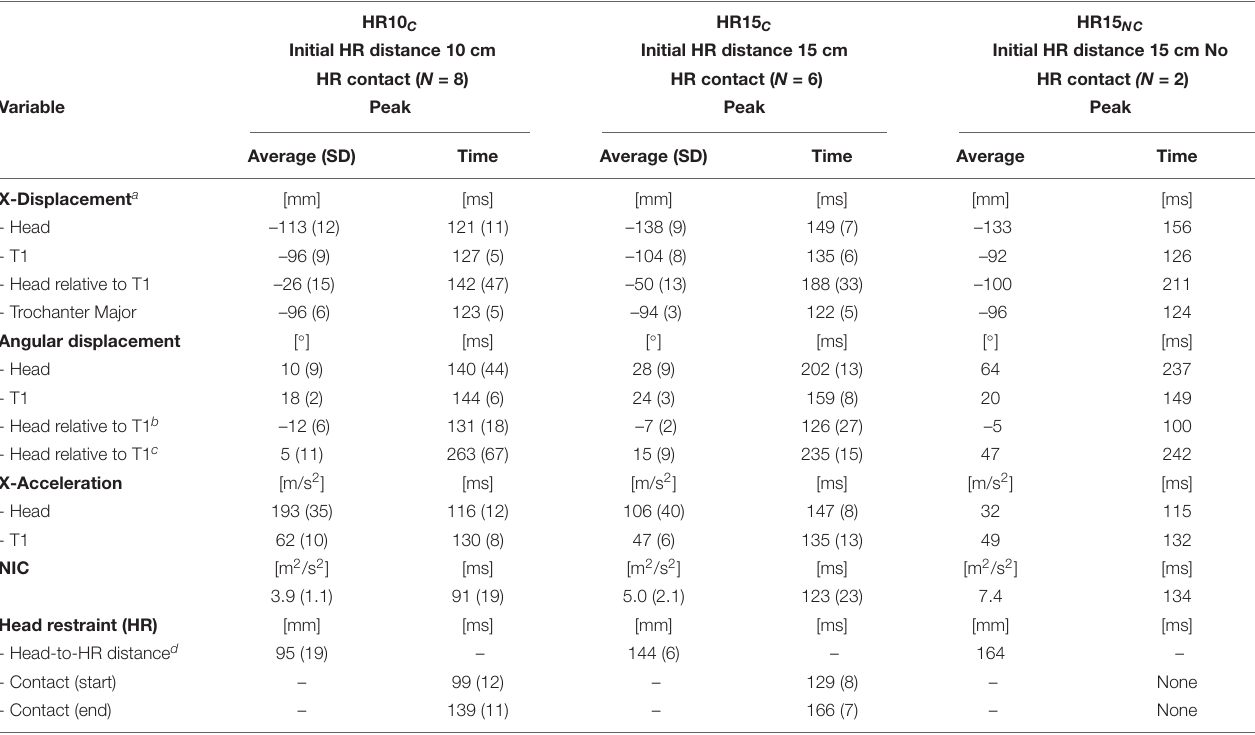
TABLE 2 | Summary of results from the tests comprising near 50th percentile female